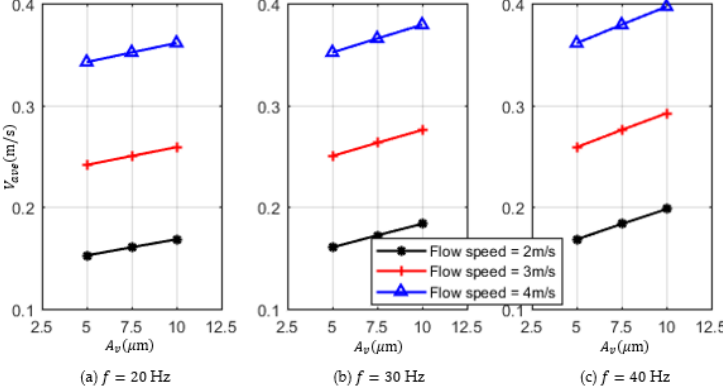
Figure 13a Effect of electrolyte flow speed on particle average flushing speed at every vibration frequency.